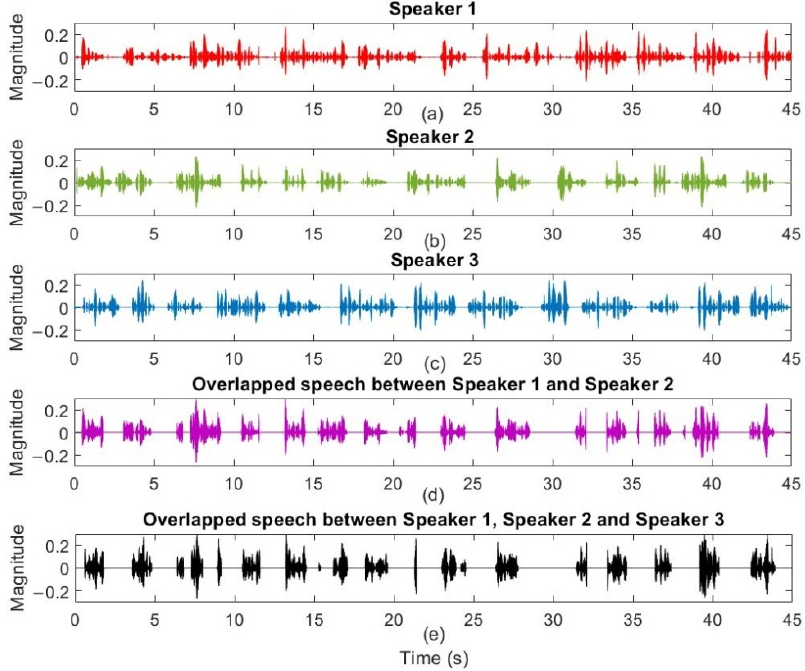
Figure 8. The time-domain speech signal, ( a ) first speaker, ( b ) second speaker, ( c ) third speaker, ( d ) overlapped between 2 speakers (speaker 1 and speaker 2), and ( e ) overlapped between 3 speakers.